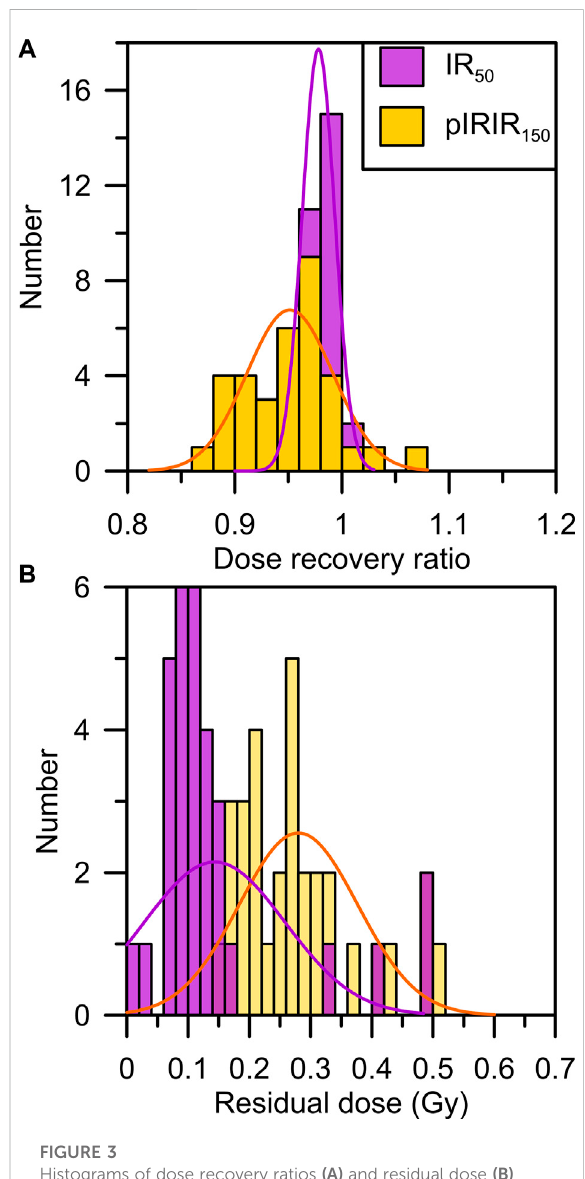
FIGURE 3 Histograms of dose recovery ratios (A) and residual dose (B) for the IR 50 and pIRIR 150 signals for all the samples. The dose recovery ratio and residual dose were determined using three aliquots for each